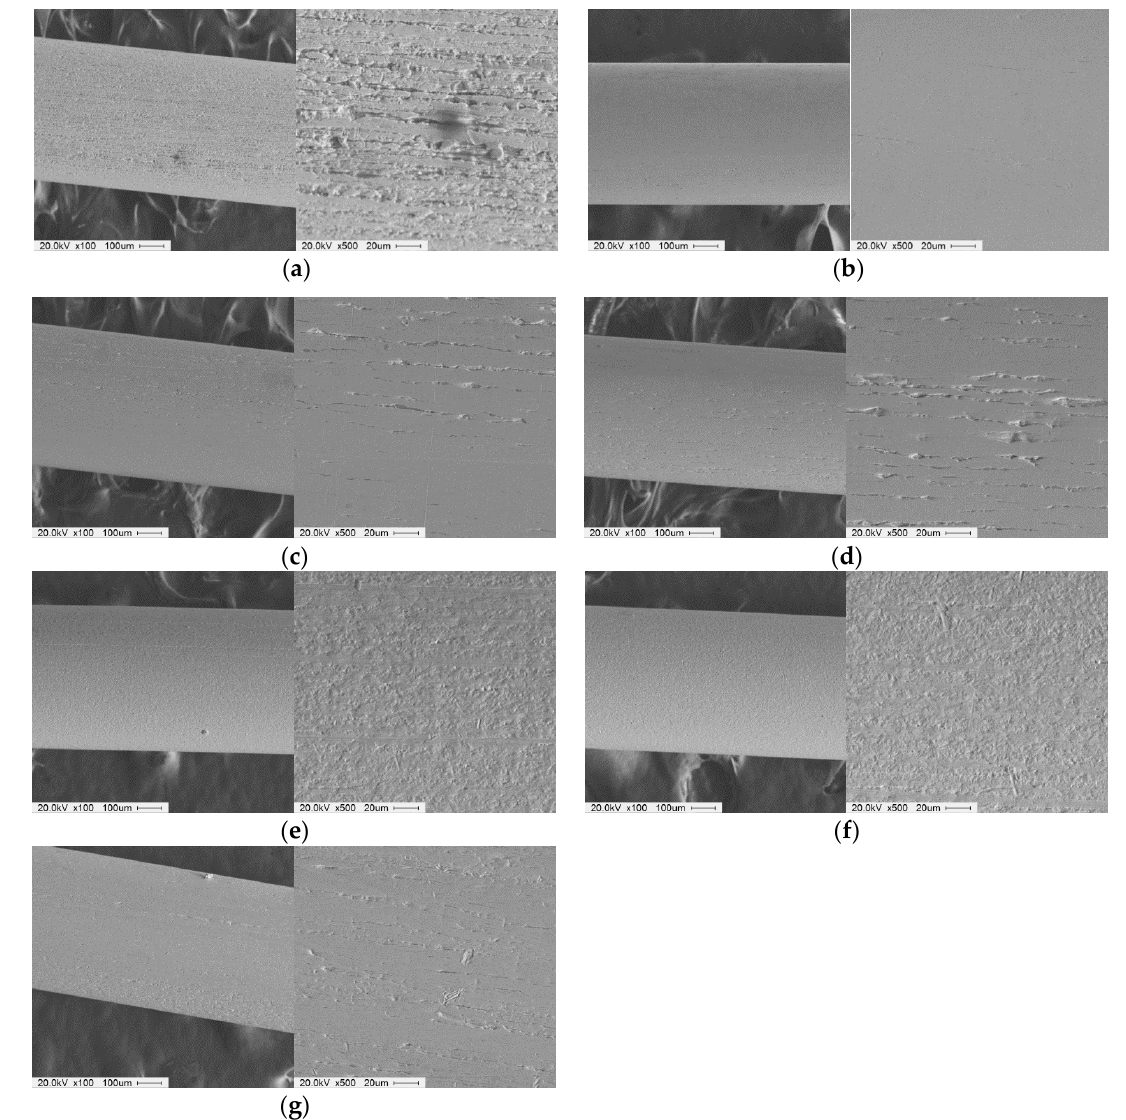
Figure 8. SEM micro pictures of the wire workpiece surface before and after processing by an ultra-high-precision magnetic abrasive finishing using a rotating magnetic field (SEM at 100× and 500×). ( a ) Before finishing (Ra: 0.25 µm) ( b ) After finishing (Ra: 0.02 µm, magnetic abrasive: 0.5 µm, rotational speed: 800 rpm, 10 Hz, 60 sec) ( c ) After finishing (Ra: 0.05 µm, magnetic abrasive: 0.5 µm, rotational speed: 350 rpm, 10 Hz, 60 sec) ( d ) After finishing (Ra: 0.05 µm, magnetic abrasive: 0.5 µm, rotational speed: 600 rpm, 10 Hz, 60 sec) ( e ) After finishing (Ra: 0.14 µm, magnetic abrasive: 3 µm, rotational speed: 800 rpm, 10 Hz, 60 sec) ( f ) After finishing (Ra: 0.14 µm, magnetic abrasive: 6 µm, rotational speed: 800 rpm, 10 Hz, 60 sec) ( g ) After finishing (Ra: 0.04 µm, magnetic abrasive: 0.5 µm, rotational speed: 800 rpm, 4 Hz, 60 sec).